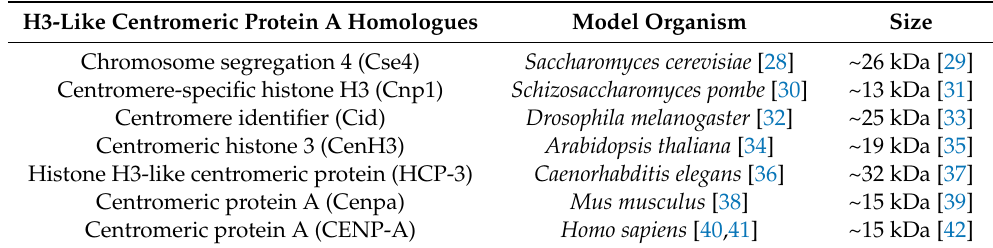
Table 2. H3-like centromeric protein A homologues in di ff erent model